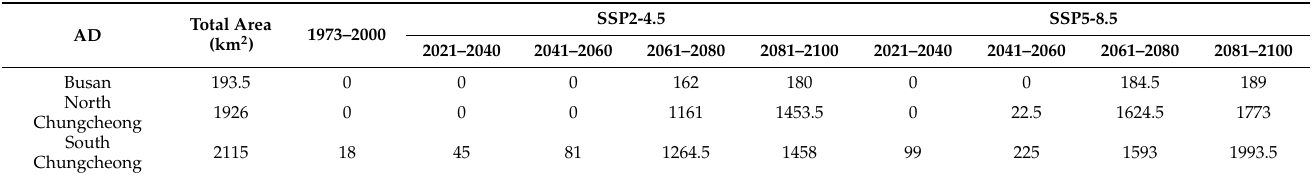
Table 5. Estimation of suitable habitat for P. hysterophorus in the different ADs of South Korea under the current climate (1973–2000) and future climate scenarios (SSP2-4.5 and SSP5-8.5;